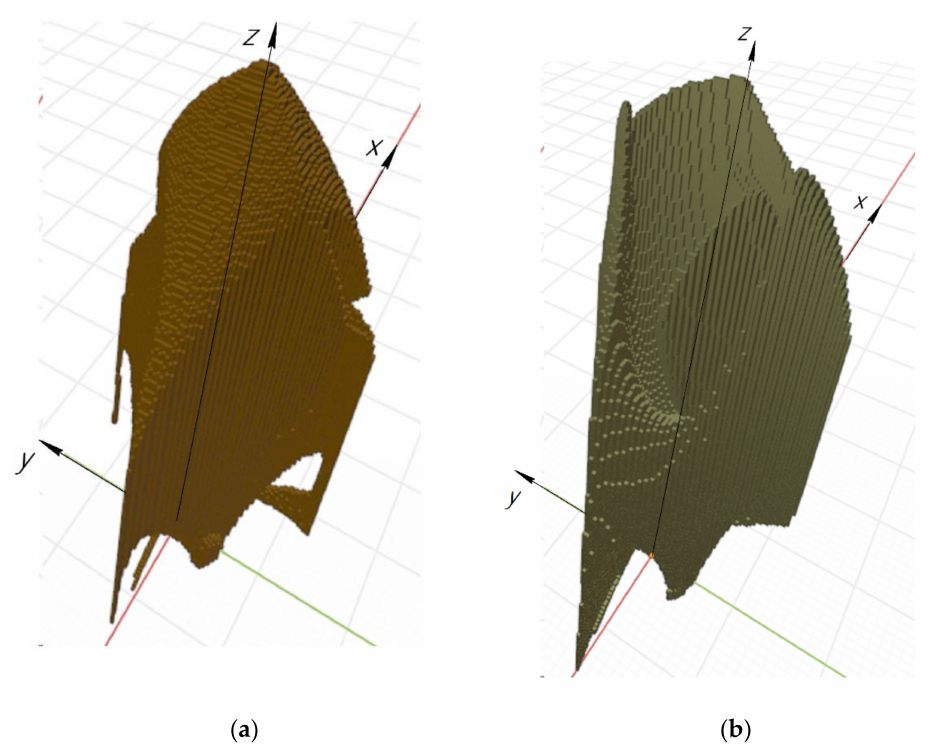
Figure 8. Workspace of the parallel manipulator—( a )—with a negative sign of the determinant of the Jacobi matrix, ( b )—with a positive